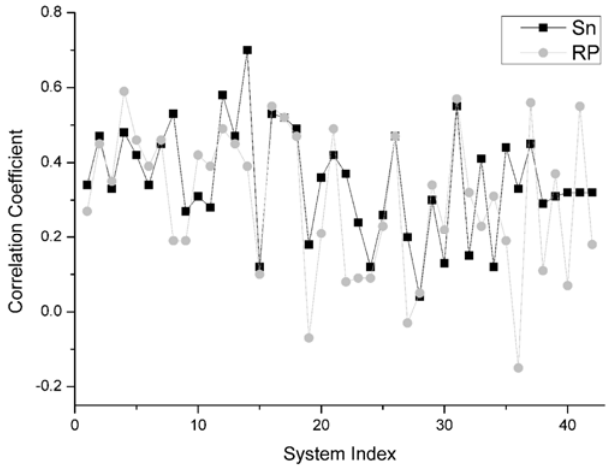
Figure 5. For the unbound dock results, the comparison of the correlation between the score value and the L_RMSD for Sn and RP score.